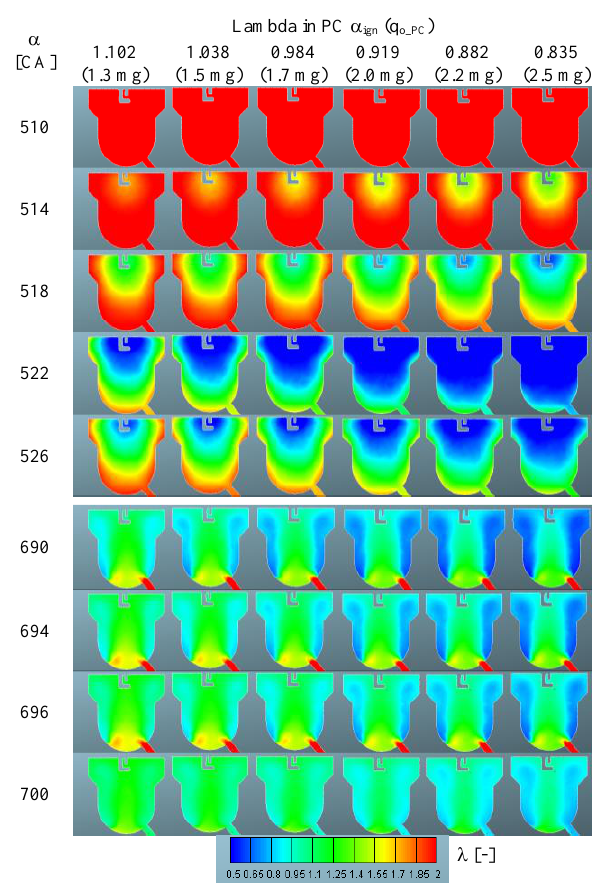
Fig. 6. Air excess ratio in prechamber for different fuel dose values q o_PC